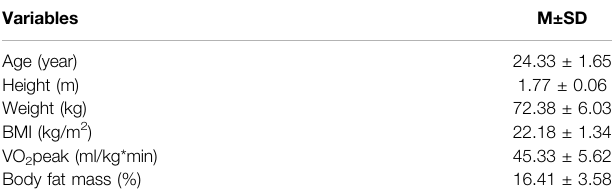
TABLE 1 | Basic characteristics of the participants (M ± SD n =